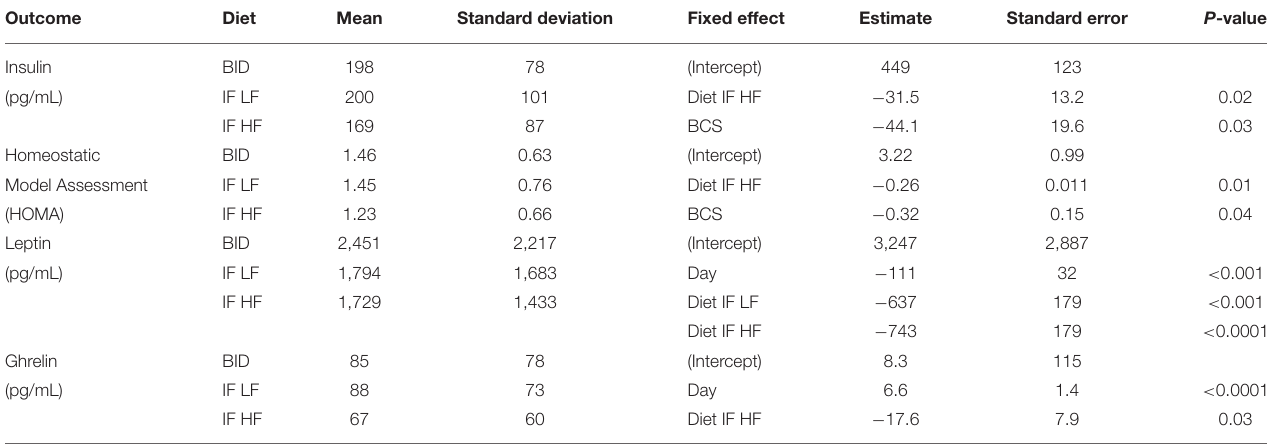
TABLE 4 | The means and standard deviations for insulin, Homeostatic Model Assessment (HOMA), leptin and ghrelin, and the results of the linear mixed effect models, of 10 dogs fed daily (BID), and intermittently fasted on a low fat (IF LF) and a high fat diet (LF HF) in a Latin Square design. Outcome